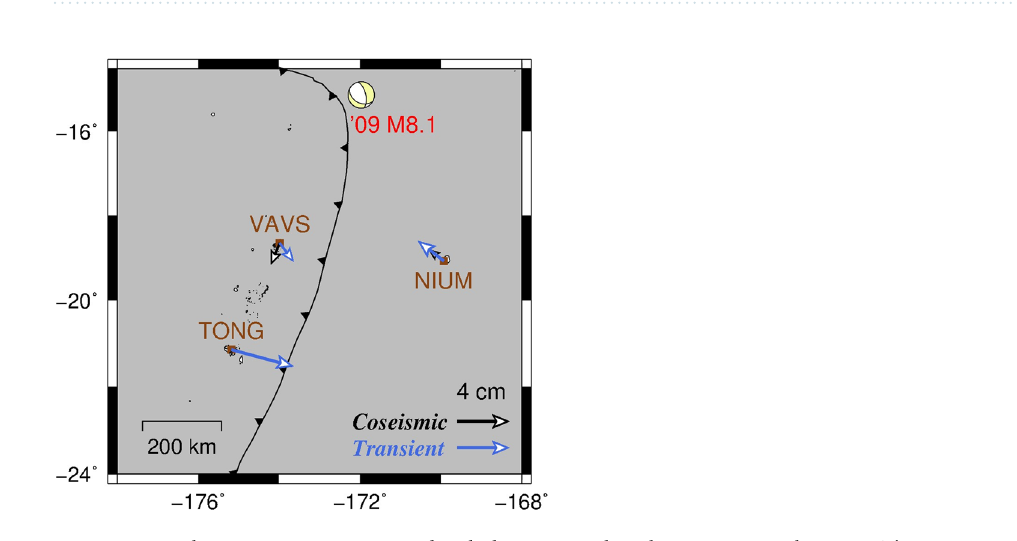
Figure 3. Detrended GNSS time series of the East–West component at TONG station, where we removed the coseismic offsets of the large earthquakes (vertical red broken lines) in Fig. 1. We define four periods, P1, P2, P3, and P4, bounded by the time of the large earthquakes. During P2, the logarithmic decay of the eastward displacements fitted by the green chain line (the relaxation time is about 0.024 years, equal to 8.8 days) was observed. During P3, the eastward displacements linearly increased. Figure generated with R 3.x (https ://www.r- proje ct.org/).